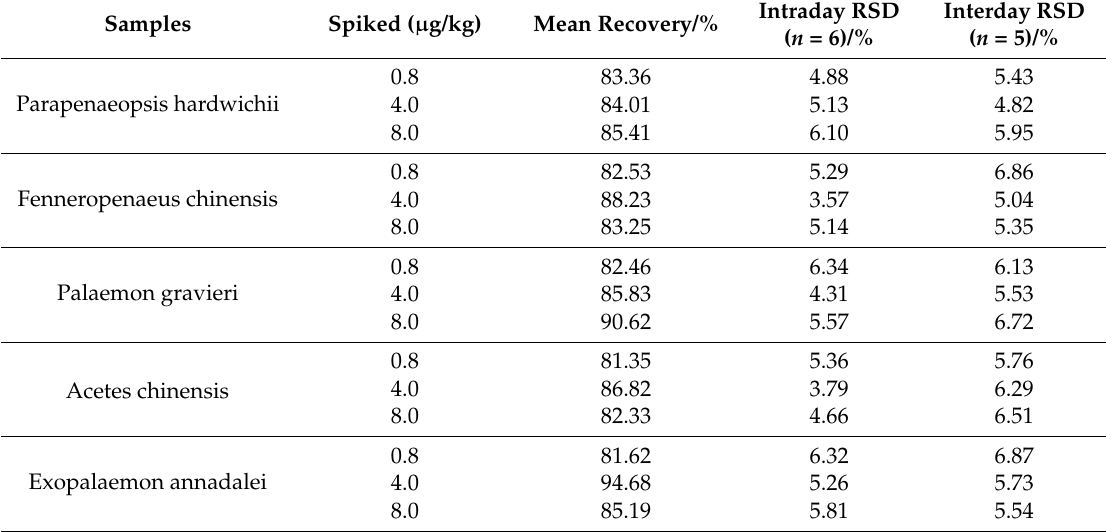
Table 1. Recoveries and precision (RSDs) of 4-HR from spiked shrimp samples. Samples Spiked ( µ g/kg) Mean